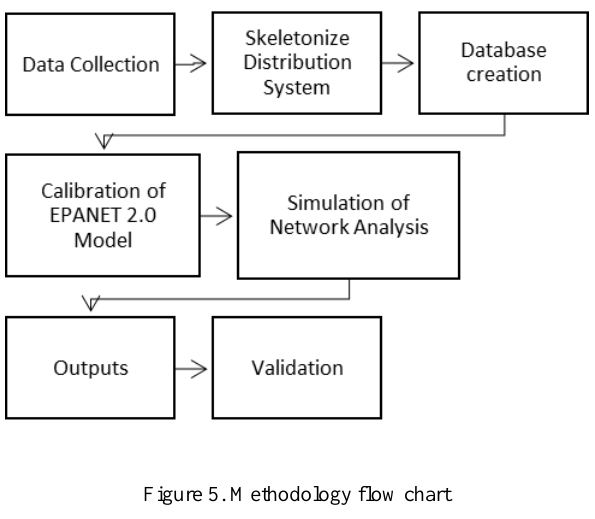
Figure 5. Methodology flow